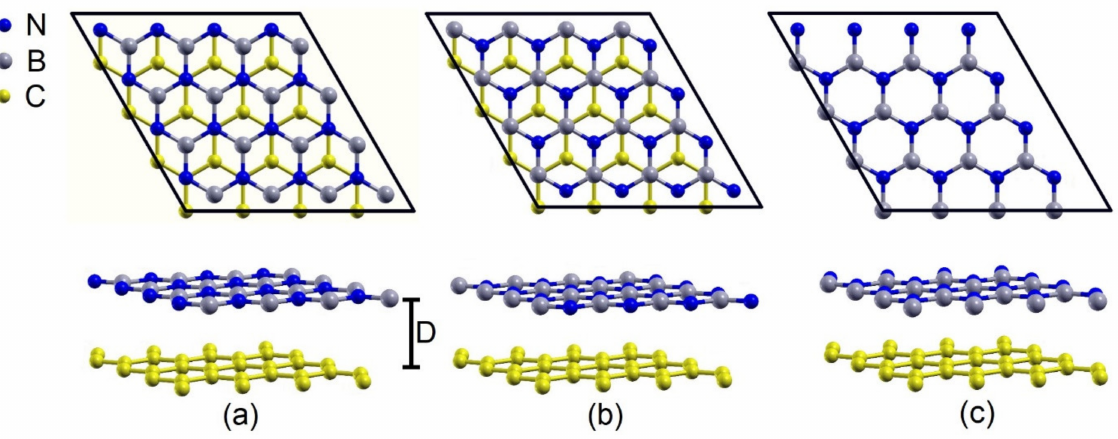
Figure 1. (4 × 4) BN-h (4 × 4)/graphene heterostructure ( a ) B-centered stacking, ( b ) N-centered stacking, and ( c ) h-centered stacking.